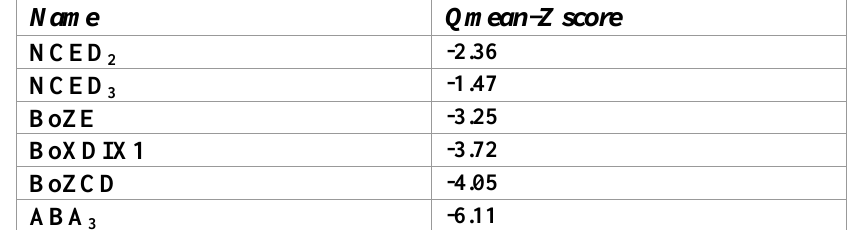
Table 6. Structure assessment via Qmean Z